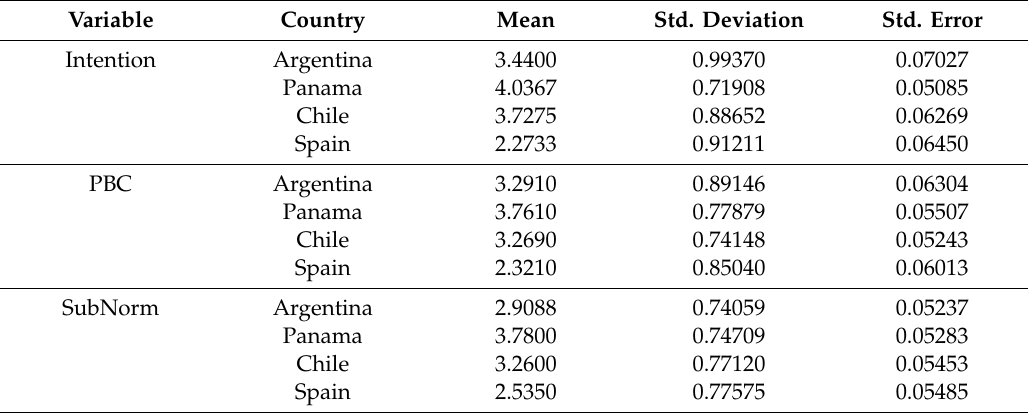
Table 3. Mean, Standard Deviations and Error by